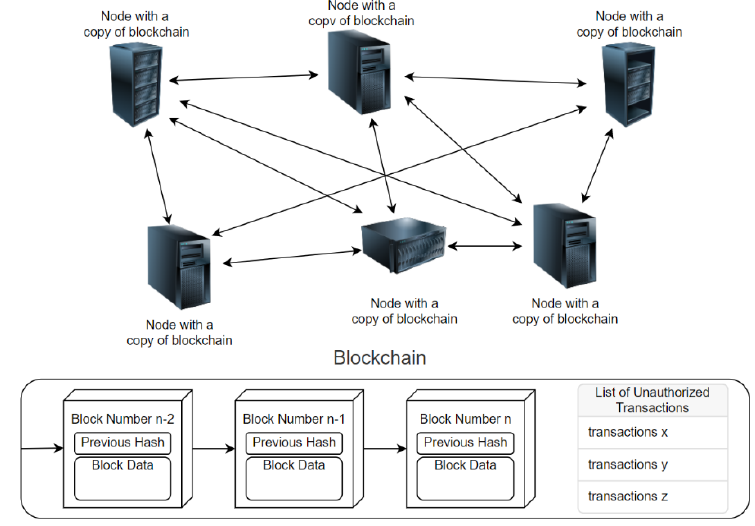
Figure 1. Basic blockchain structure.